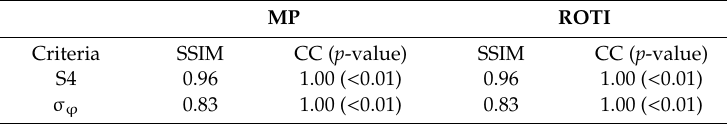
Table 8. SSIM and CC between the maps shown in Figure 8b.